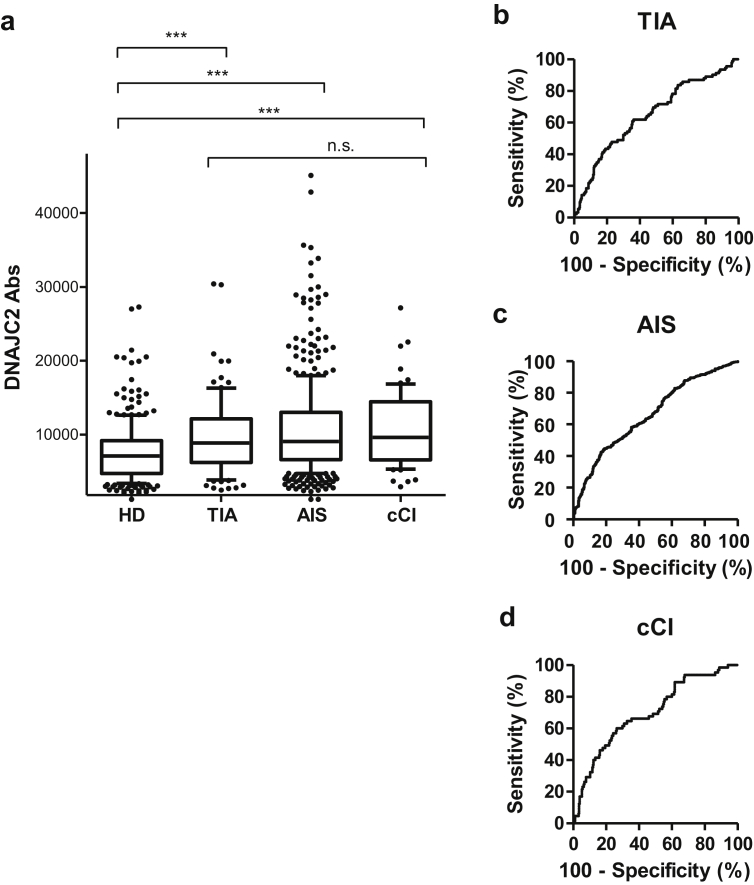
Serum levels of DNAJC2 antibodies (DNAJC2-Abs) in stroke patients examined by amplified luminescent proximity homogeneous assay-linked immunosorbent assay (AlphaLISA) in the validation cohort. The DNAJC2-Ab levels measured as Alpha photon counts were compared between the HDs and the patients with TIA, AIS, or chronic-phase cerebral infarction (cCI) in box-whisker plots displaying the 10th, 20th, 50th, 80th, and 90th percentiles (a). ∗∗∗p < 0.001 by the Mann–Whitney U test with type I error adjustment using the Bonferroni procedure, not significant (n.s.), p = 1 by the Kruskal–Wallis test with type I error adjustment using the Bonferroni procedure. Receiver operating characteristic curve (ROC) analysis was performed to assess the ability of DNAJC2-Abs to detect TIA (b), AIS (c), and chronic cerebral infarction (cCI) (d). Table 3 summarizes areas under the curves (AUCs), 95% confidence intervals (CIs), cutoff values, sensitivity, specificity, and p values calculated using ROC analysis.